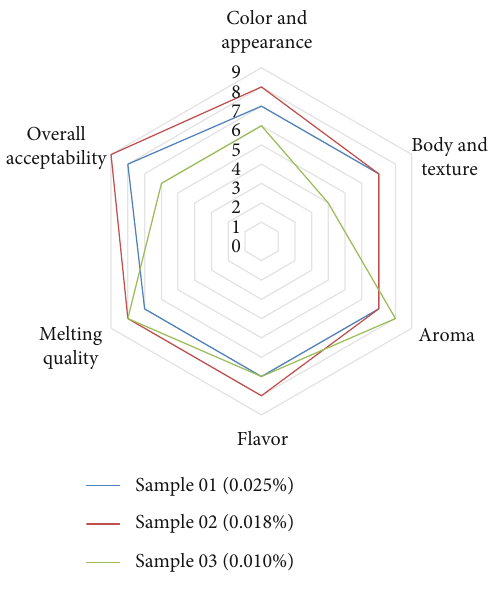
Figure 1: Graphical design for sensory analysis of coconut milk- based spicy ice